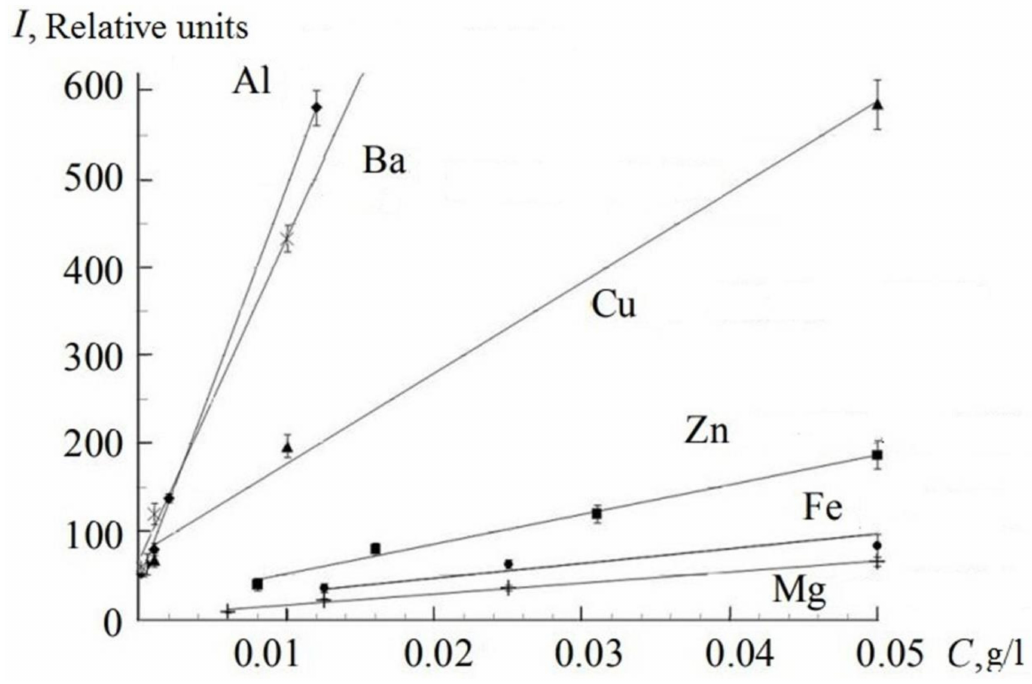
Figure 11. Calibration curves for determining the content of Al, Zn, Cu, Ba, Fe, Mg in water